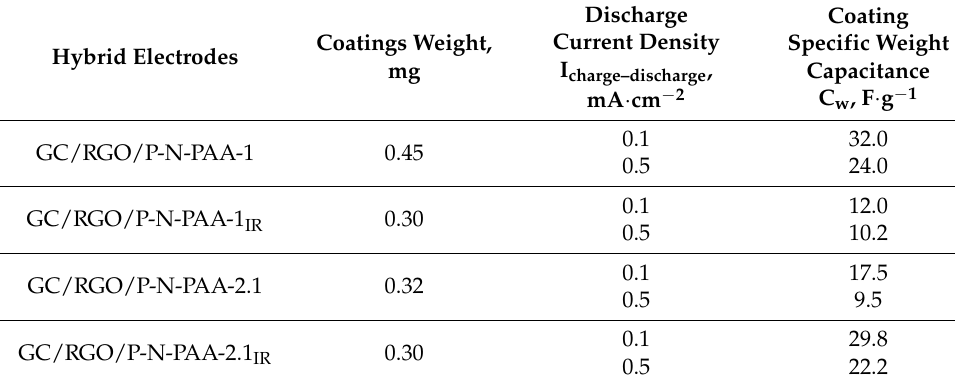
Table 4. Electrochemical characteristics of GC/RGO/P-N-PAA